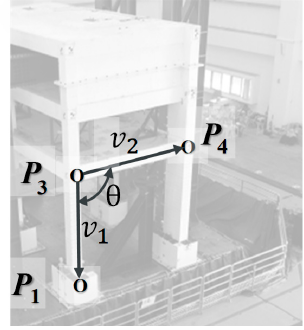
Figure 16. Estimation of first-floor drift angle. The story drift history is estimated by angle calculation to avoid error induced by the shake table rotation.